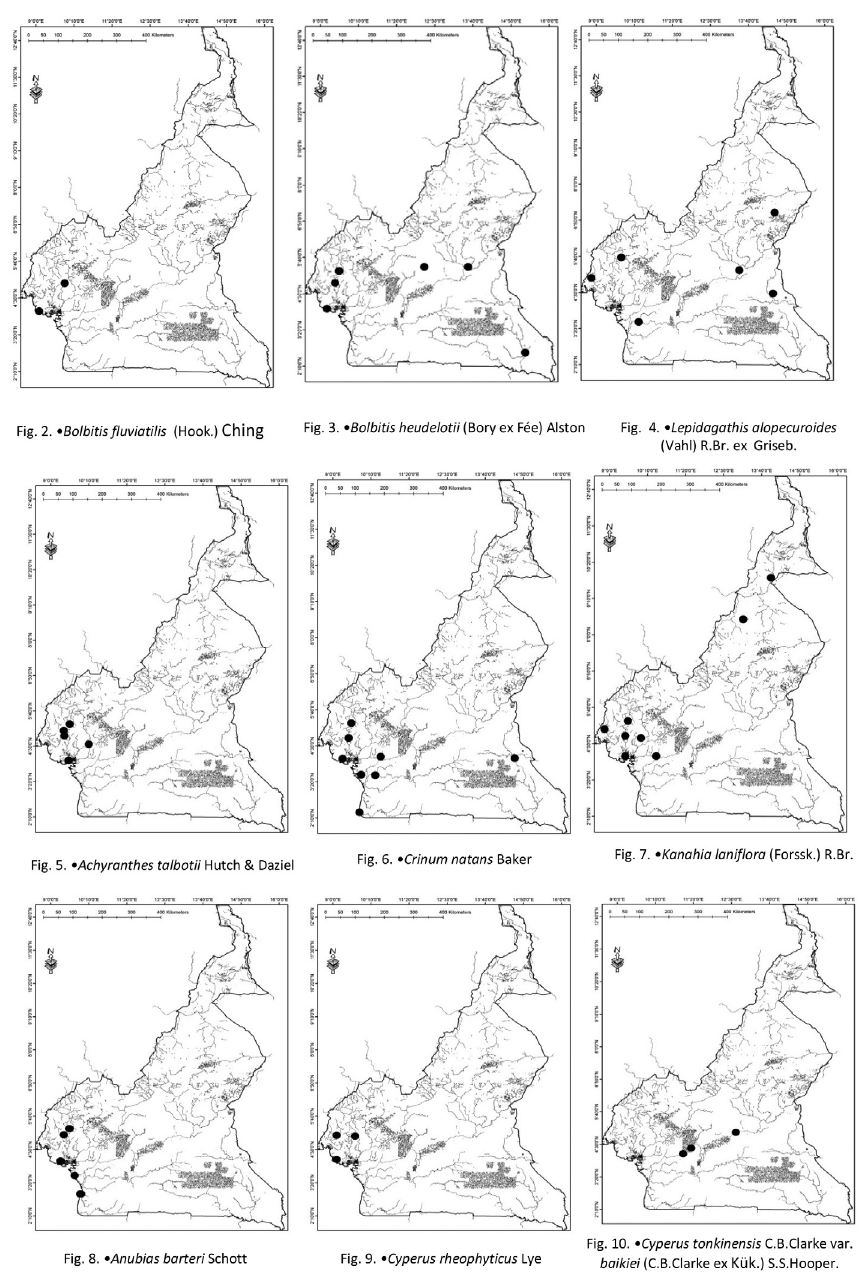
Figures 2–10. 2 Bolbitis fluviatilis (Hook.) Ching 3 Bolbitis heudelotii (Bory ex Fée) Alston 4 Lepidagathis alopecuroides R.Br. ex Griseb. 5 Achyranthes talbotii Hutch & Daziel 6 Crinum natans Baker 7 Kanahia lani- flora (Forssk.) R.Br. 8 Anubias barteri Schott 9 Cyperus rheophyticus Lye 10 Cyperus tonkinensis C.B.Clarke var. baikiei (C.B.Clarke ex Kuk)